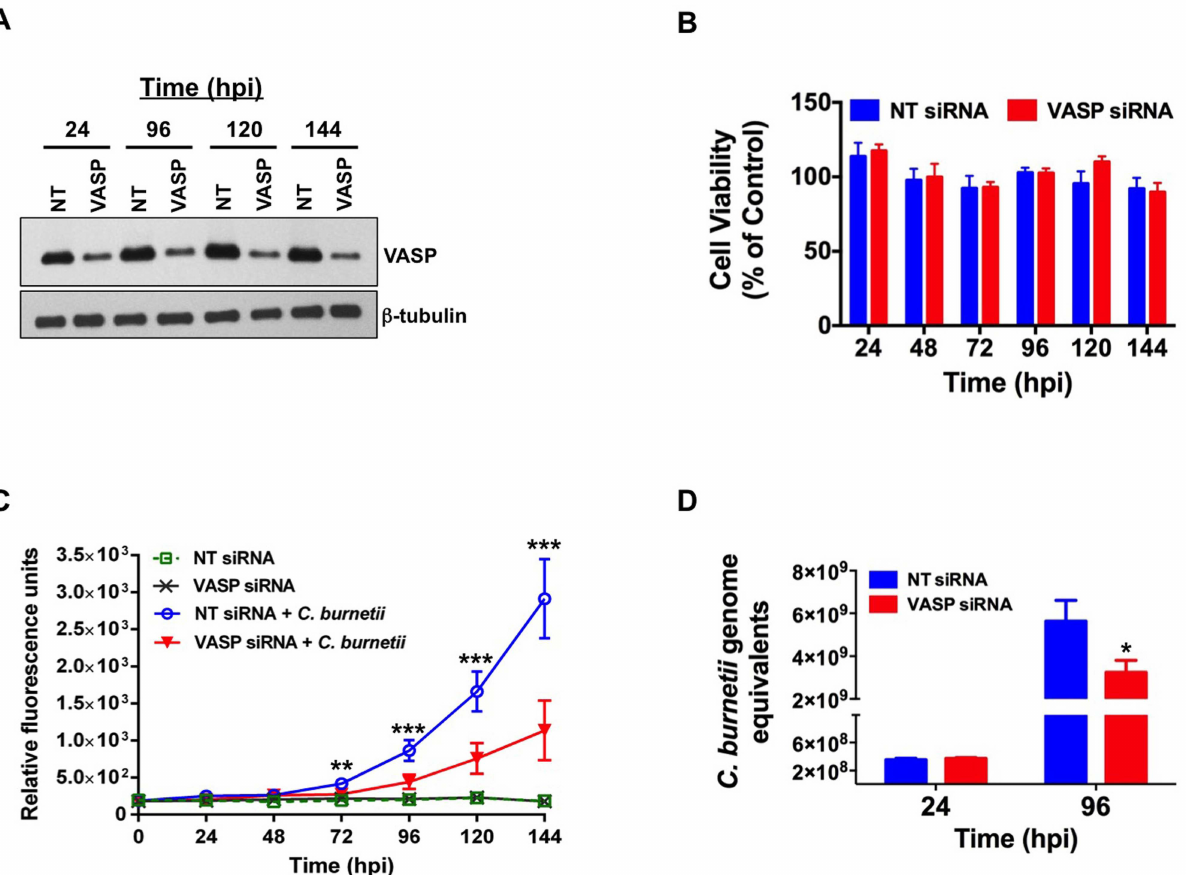
Fig 4. VASP activity is required for optimal C . burnetii intracellular replication. THP-1 cells were transfected with non-targeting(NT) or VASP-specific siRNA and harvested at 24–144hpi. (A) Immunoblot analysis confirmed > 80% knockdownof VASP productionin VASP siRNA-transfected cells. (B) A viabilityassay demonstrated that no significant cell death occurred in VASP-depleted cells. (C) siRNA- transfected THP-1 cells were infected with C . burnetii expressing mCherry. Fluorescence was measured for 6 days after infection using a microplate reader (585/620nm excitation/emission). (D) Bacterial genomeequivalentswere determined at 24 and 96 hpi using quantitative PCR. Each data point represents an average of seven replicates collectedfrom two independent experiments, and error bars indicate standard deviationfrom the mean. * indicates p < 0.05, ** indicates p < 0.0005, and *** indicates p < 0.0001 accordingto a Student’s t test comparingNT and VASP-silenced cells infected with C . burnetii -mCherry. Depletionof VASP significantly impairs C . burnetii